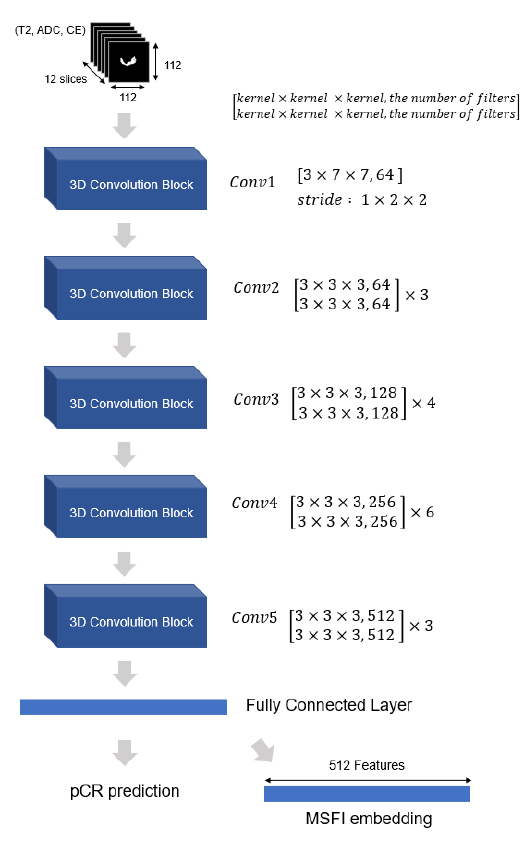
Figure 3. Architecture of the 3D-CNN classifier for MSFI embedding